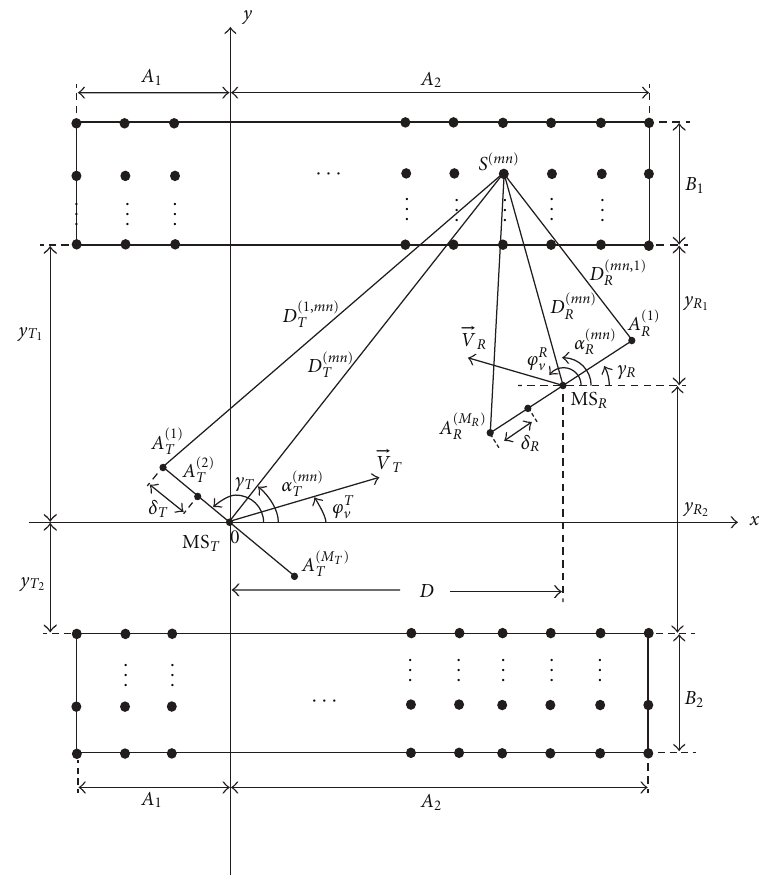
Figure 2: The geometrical street scattering model with local scatterers uniformly distributed in two rectangular areas on both sides of the